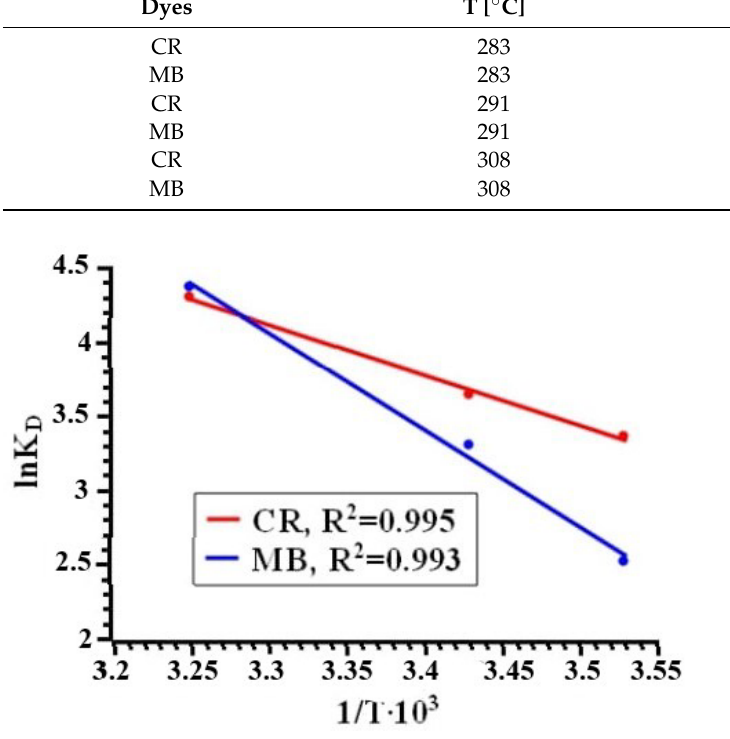
Figure 12. Dependence of the distribution constant on the reciprocal temperature.